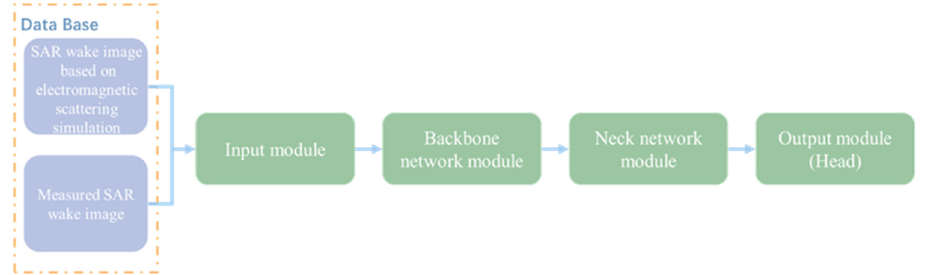
Figure 1. Diagram of the relationship between the YOLOv5 method and electromagnetic scattering modeling.